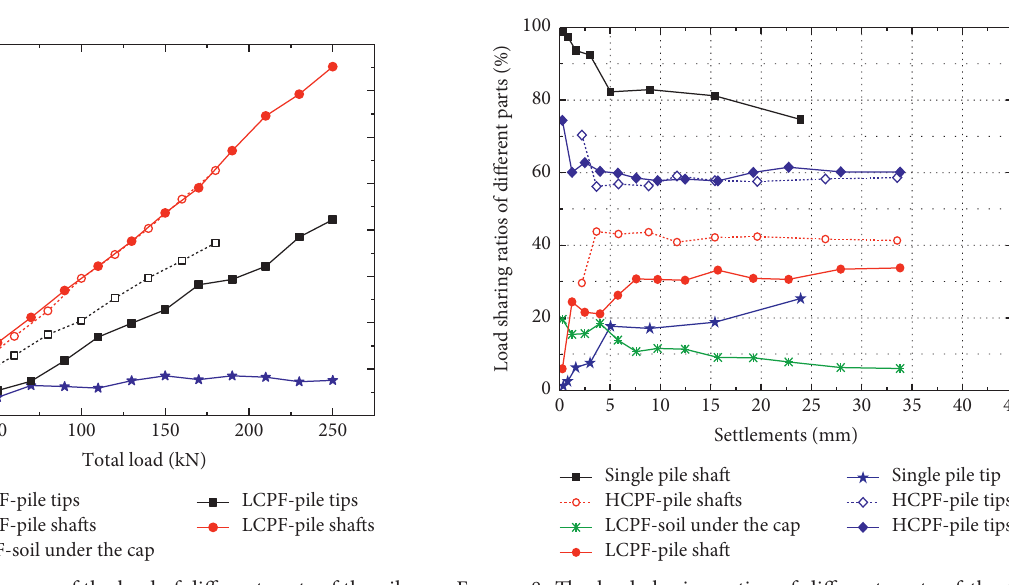
Figure 8: The load sharing ratios of different parts of the foun- dation versus the